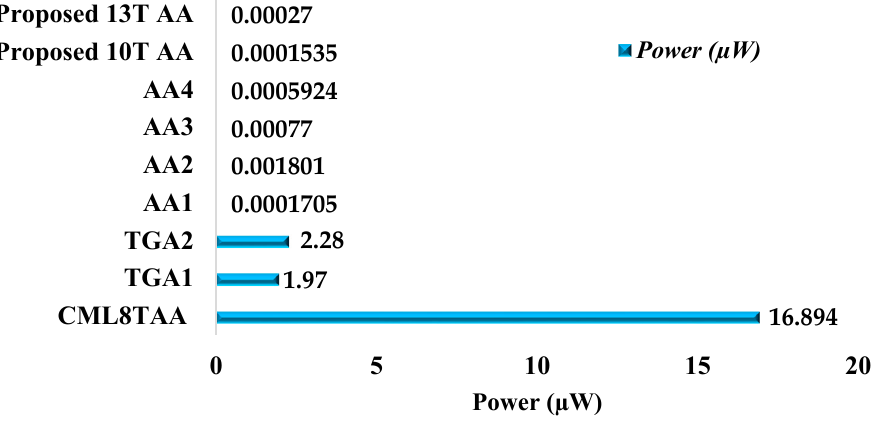
Figure 10. Power ( µ W) vs. existing and proposed circuits. Figure 10. Power (µW) vs. existing and proposed circuits. Figure 10. Power (µW) vs. existing and proposed circuits.